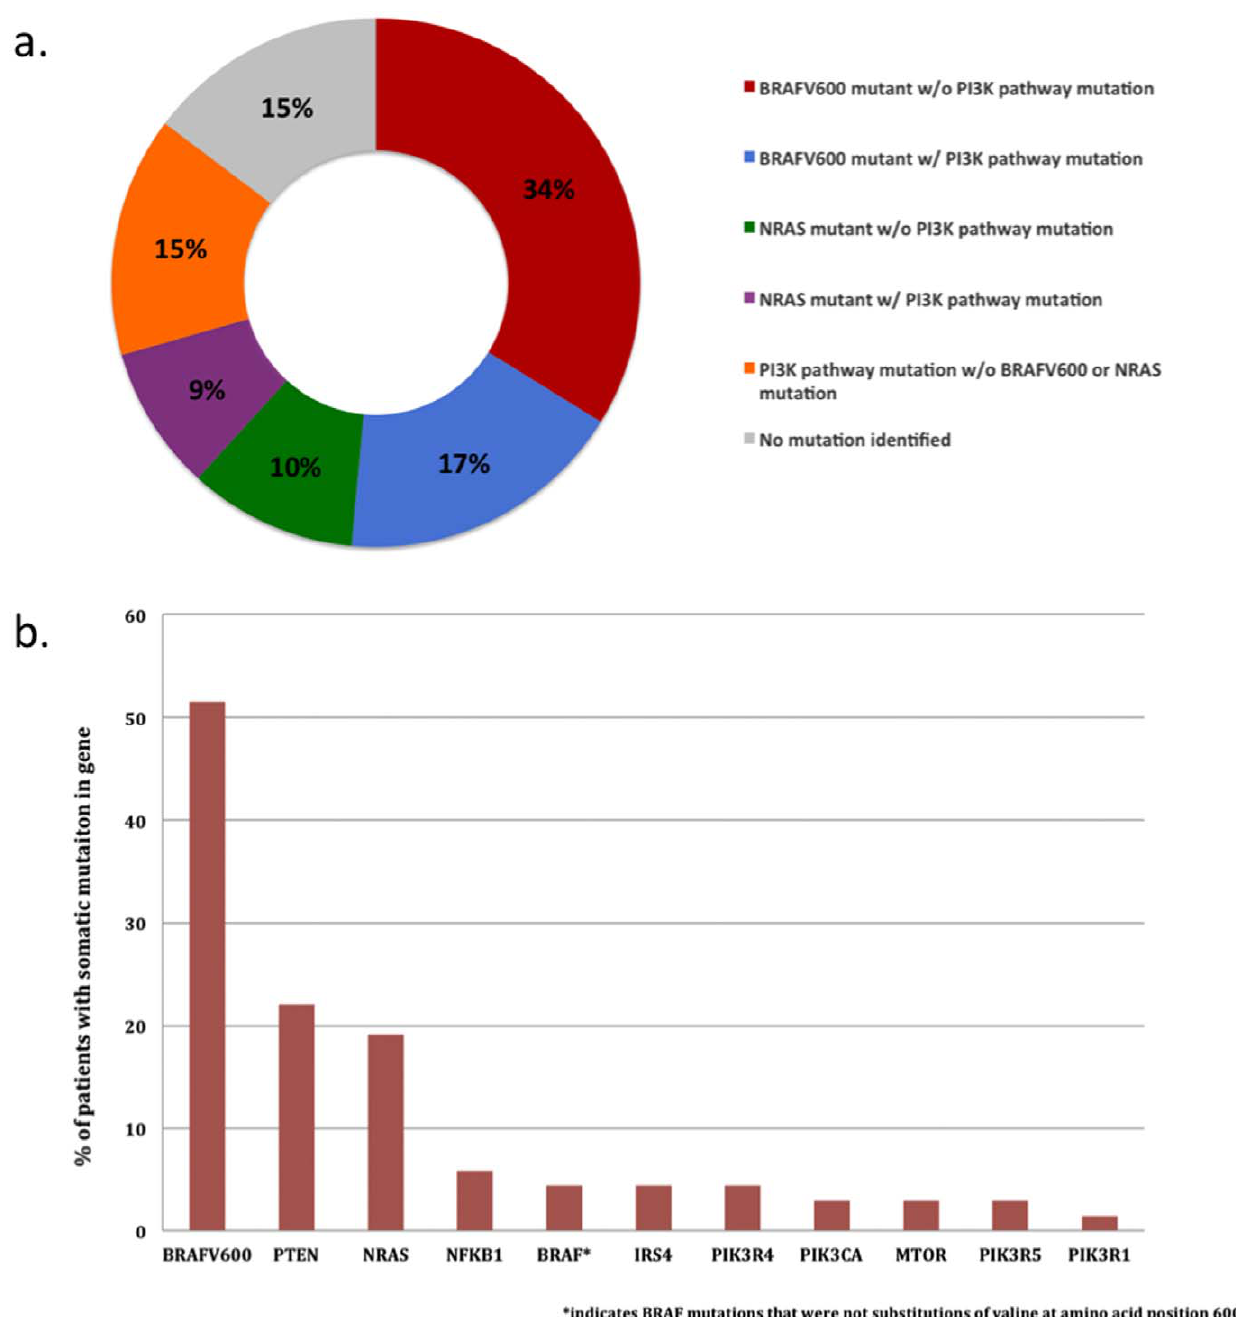
Figure 3. Distribution of melanoma patients according to pathway somatic mutations. (a) Percentages of melanomas that have: a BRAF V600 mutation without a PI3K pathway mutation, a BRAF V600 mutation with a PI3K pathway mutation, a NRAS mutation without a PI3K pathway mutation, a NRAS mutations with a PI3K pathway mutation, and a PI3K pathway mutation with wild-type BRAF V600 and NRAS. (b) Number of patients who carried the somatic mutations identified by Sanger sequencing.